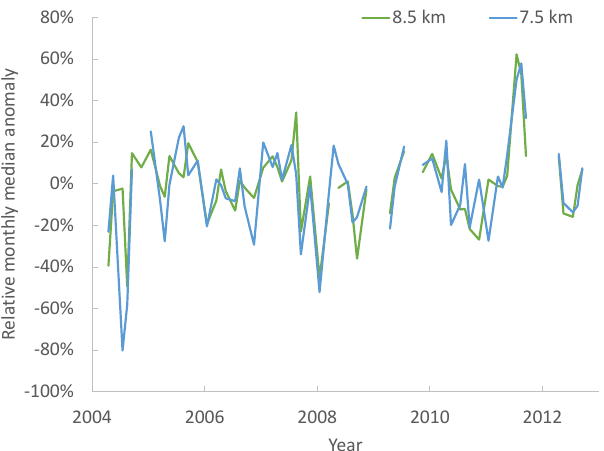
Figure 5. Enhancement factor for the water vapour mixing ratio in July 2011 in the 40–60 ◦ S band (1–12 July, N = 78) and the 60– 66 ◦ S band (13–31 July, N = 181), relative to July 2012. The error bars on the ratio profiles account for 1 standard error of the MAE- STRO monthly mean for both years, combined in quadrature.